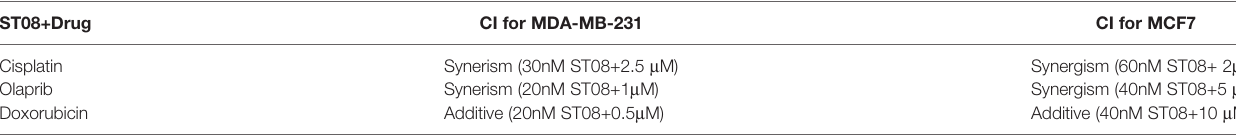
TABLE 3 | Combination index(CI) for different drug combinations in MDA-MB-231, MCF7 cells. ST08+Drug